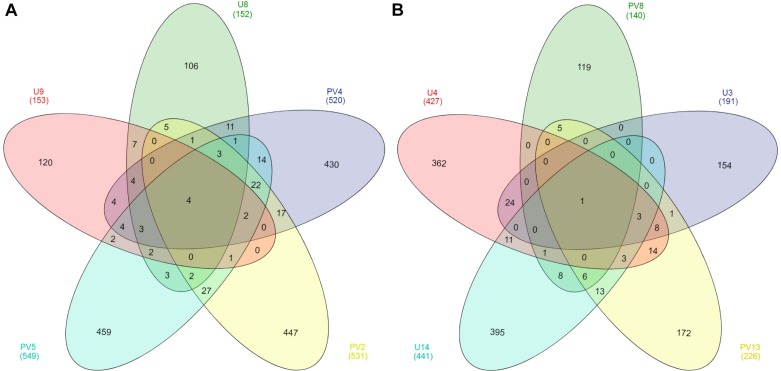
Venn diagram of OTUs present in (A) basaltic and (B) granitic zones. OTUs were based on 97% sequence similarity. The numbers inside the diagram are the number of OTUs.